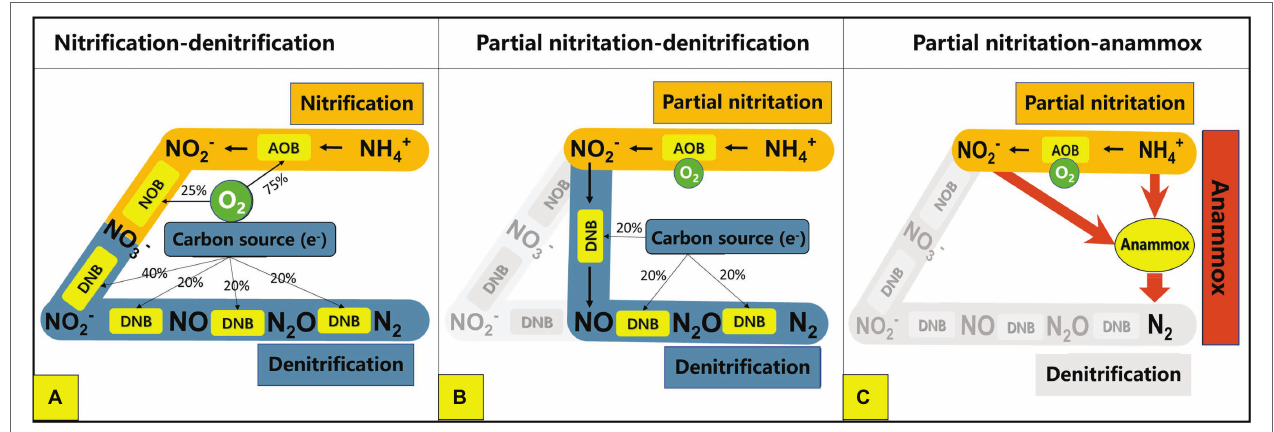
FIGURE 1 | Pathways of different biological nitrogen removal processes: (A) traditional nitrification denitrification process; (B) partial nitritation denitrification process; (C) partial nitritation anammox process. AOB, ammonia oxidizing bacteria; NOB, nitrite oxidizing bacteria; DNB, denitrifying